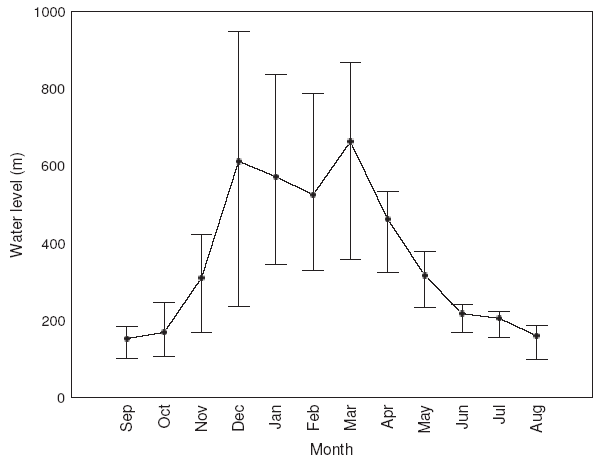
Fig. 4. Monthly variation of the frequency of gonadal maturity stages (a and b), mean gonadosomatic index (c and d), and index of reproductive activity (e and f) for females (a, c, e) and males (b, d, f) of Rhaphiodon vulpinus .